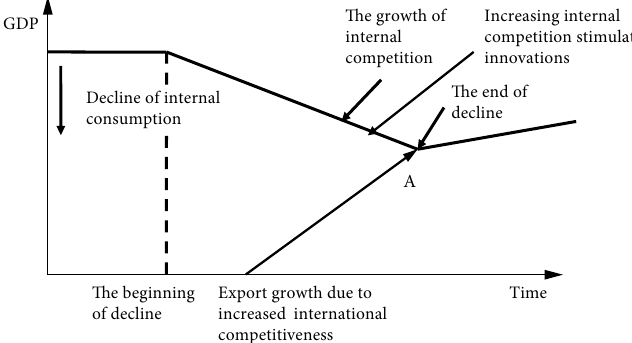
Fig. 1. The impact of recession on innovations in open market